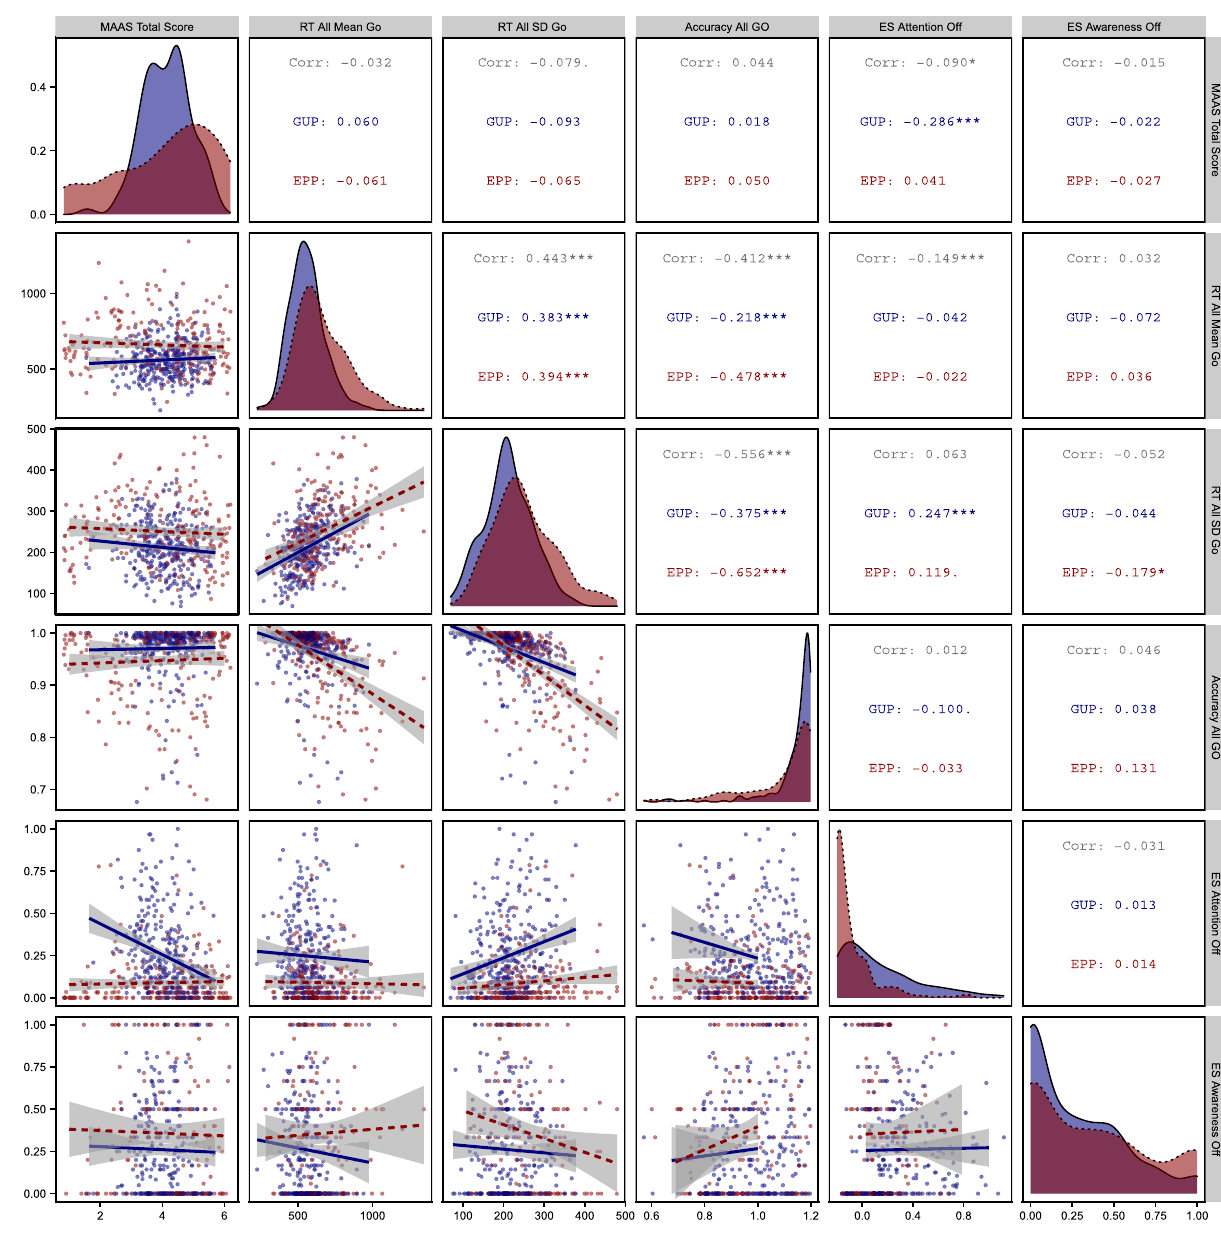
Figure 2. Pairwise Pearson correlations for MAAS, SART, and ES measures. Correlation coefficients are reported for whole sample (‘Corr’), and for EPP and GUP samples separately. Individual plots below the diagonal are scatter plots with regression lines for the two variables intersecting at this cell, those on the diagonal show density distribution plots for the two samples. Significance markers: . = p < 0.1 , * p < 0.05 , ** p < 0.01 , *** p < 0.001 . This figure was created using R (v. 4.02) 55 with packages ‘ggplot2’ (v. 3.3.5) 56 and ‘GGally’ (v. 2.1.2) 58